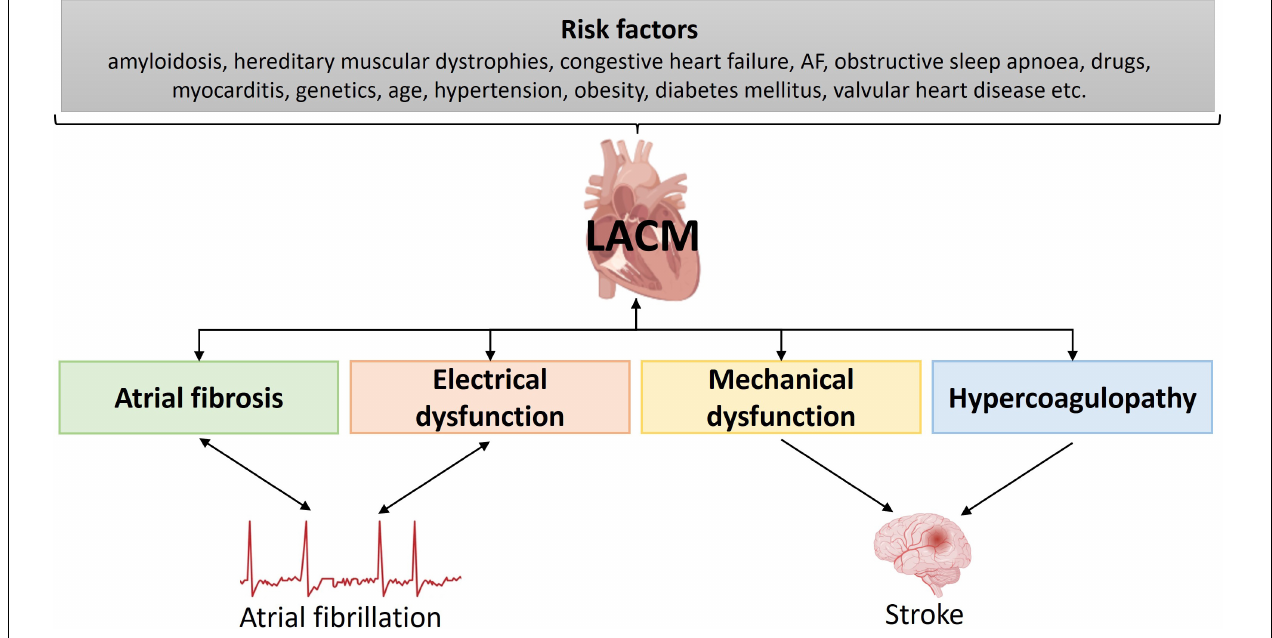
FIGURE 7 | Illustration of the underlying risk factors for left atrial cardiomyopathy. AF, atrial fibrillation; LACM, left atrial cardiomyopathy.